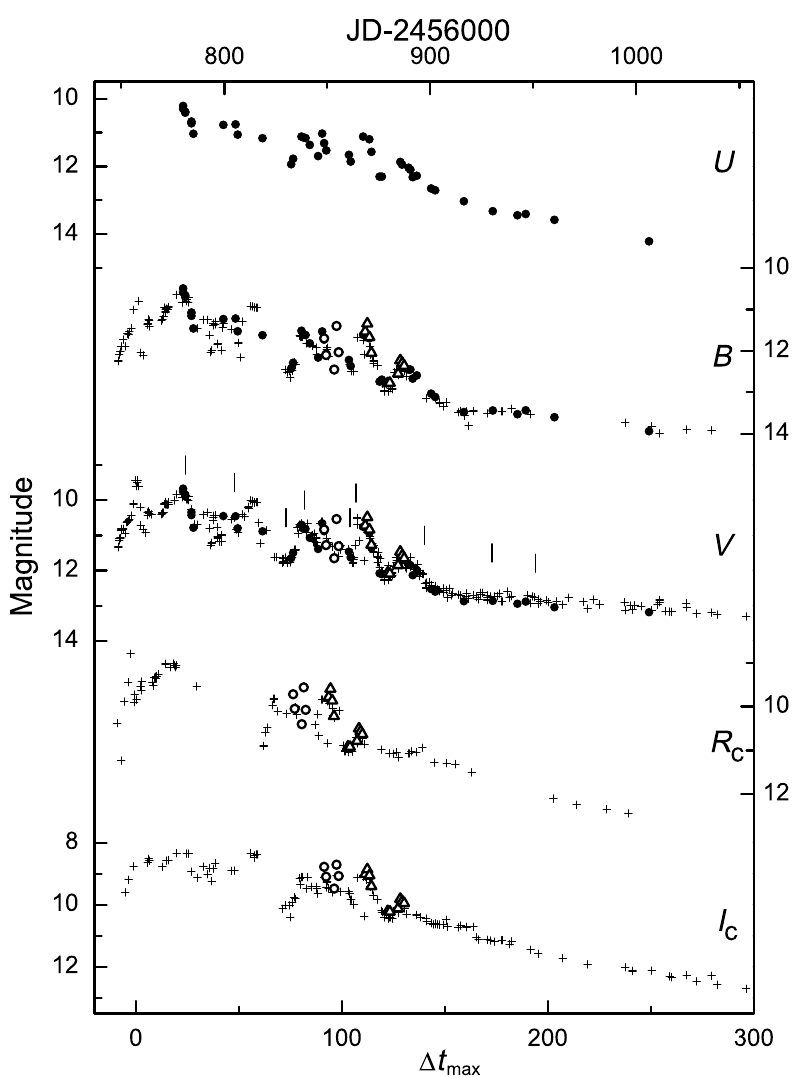
Fig. 1. The UBV R C I C light curves of V2659 Cyg. Filled circles represent photoelec- tric UBV observations; open circles and squares represent CCD magnitudes obtained with the AZT-5 and Zeiss-2 telescopes, respectively. For comparison, we also show BV RI magnitudes taken from the AAVSO database (small crosses). The short vertical lines in- dicate the epochs of our spectroscopic